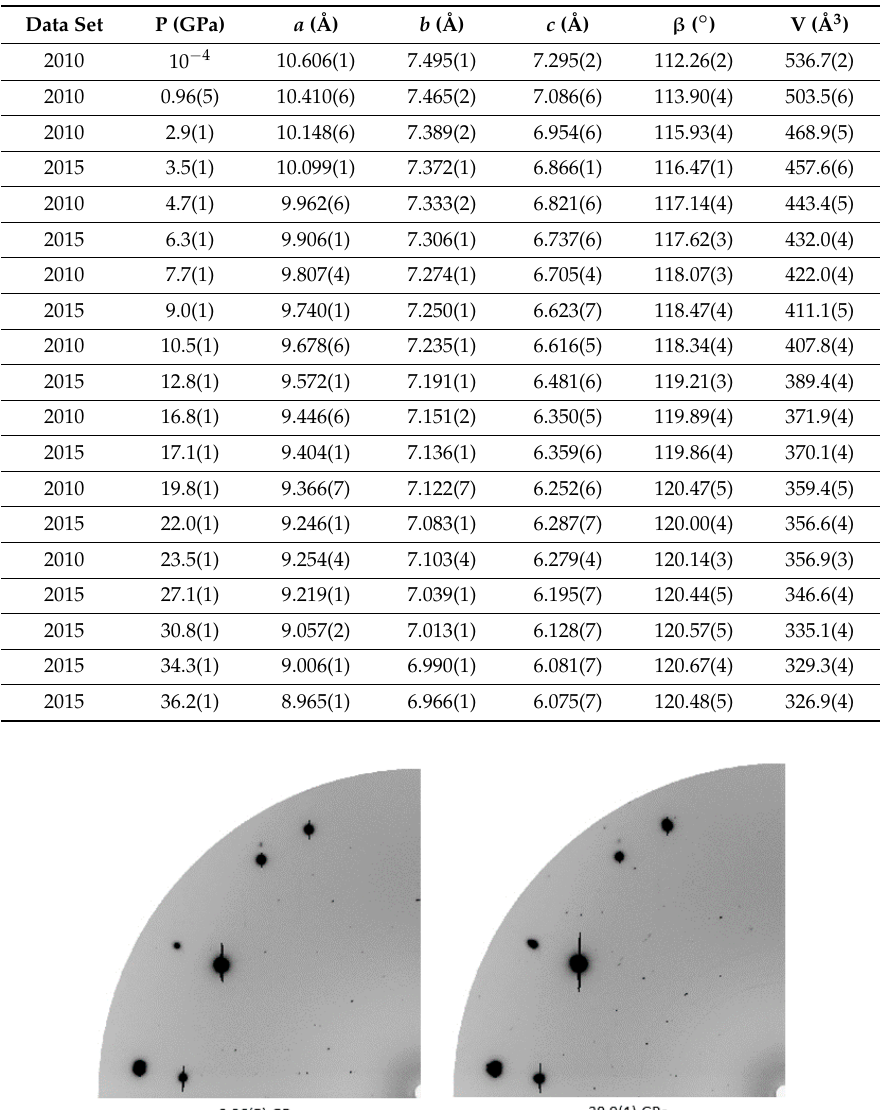
Table 1. Selected data collection and refinement details from lowest and highest pressure points. The opening angle of the diamond anvil cell in the 2015_10 experiment was larger by 20° compared to the 2010_1 experiment, producing higher number of observed peaks.